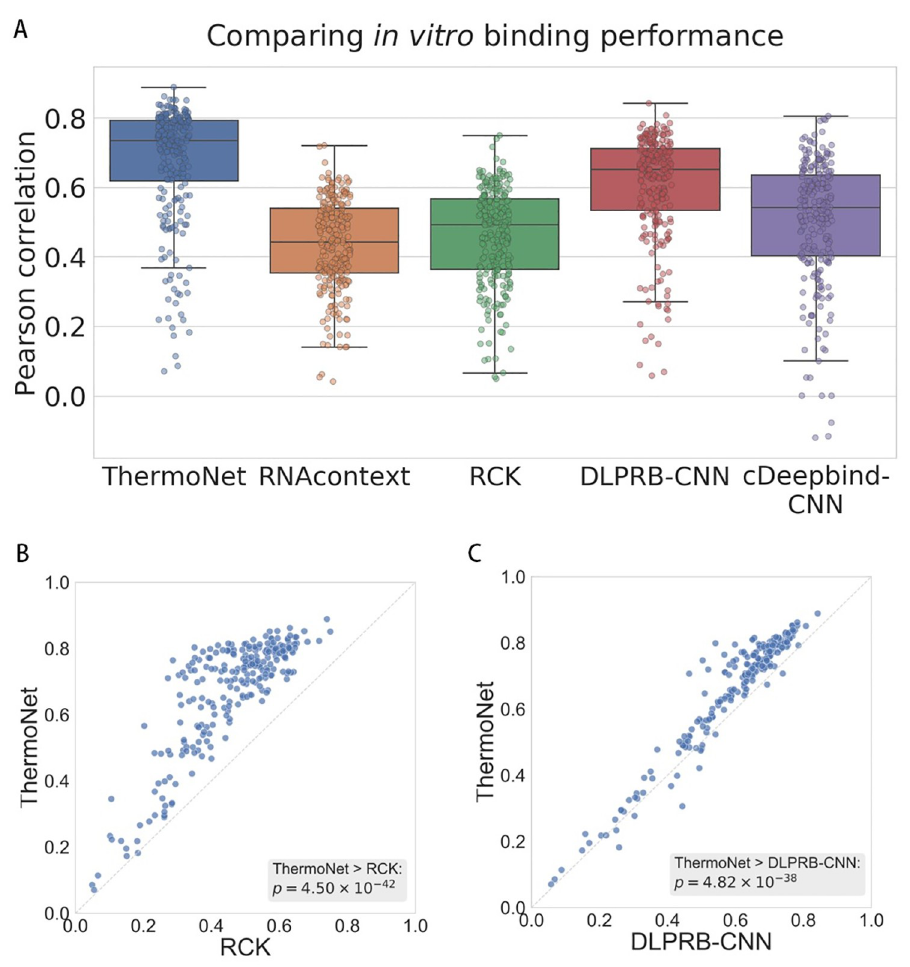
Fig 2. (A) Comparison between ThermoNet and four state-of-the-art methods in predicting in vitro binding. Performances were evaluated using the Pearson correlation between the predicted and measured binding intensities. Points in each box plot represent the 244 experiments in the RNAcompete [8] dataset. (B)-(C) Pairwise comparisons of ThermoNet to RCK [17] and DLPRB-CNN [20], respectively. The p -values were calculated using one-sided Wilcoxon singed rank